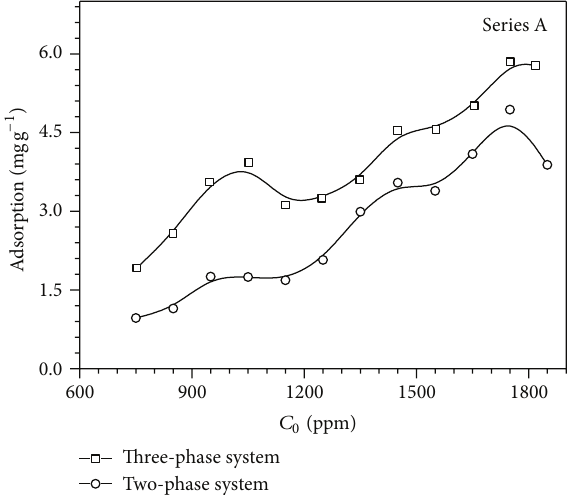
Figure 4: The isothermal adsorption of AP-P4 on the solid phase of two-phase and three-phase systems in the simulative water